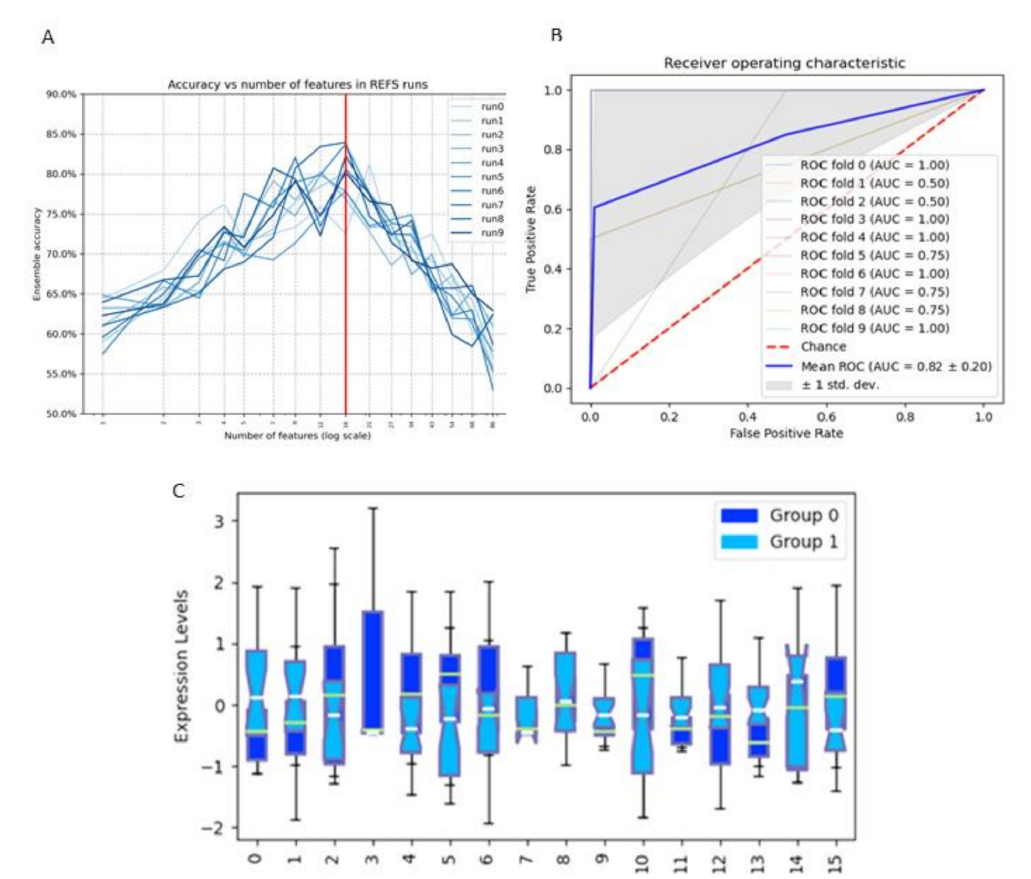
Figure 12. The datasheet of the entire study was analysed regarding the open field test (number of entries in the open field) at 8 weeks of age (early adulthood). ( A ): After running the REFS algorithm 10 times, the best signature is at 16 features with average accuracy of all classifiers of 0.77. ( B ): The optimal associated ROC curve for the best-performing classifier Ridge demonstrates an area under the curve (AUC) of 0.82 ± 0.20. ( C ): The 16 features separating the two labels: 0 = Cyanobacteria Un- classified, 1 = Oscillospira, 2 = Odoribacter, 3 = Turicibacter, 4 = AM: (DOPAC + HVA)/DA, 5 = PFC: 5HIAA/5HT, 6 = Lachnospiraceae Unspecified, 7 = Allobaculum, 8 = DH: noradrenaline